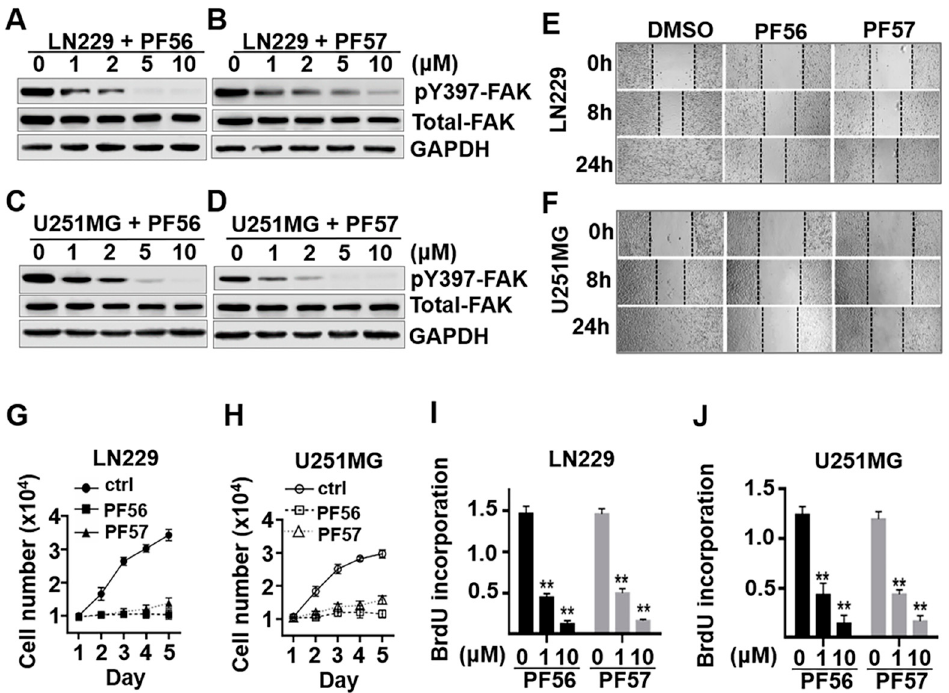
Figure 5. Blockade of FAK activation inhibits migration and proliferation in LN229 and U251MG cells. ( A – D ) FAK inhibitor PF562271 (PF56) or PF573228 (PF57), reduced the levels of the active